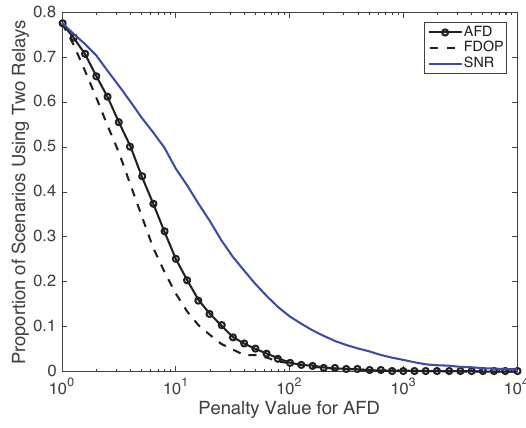
Figure 4. Use of two relays with four sources and four relays.